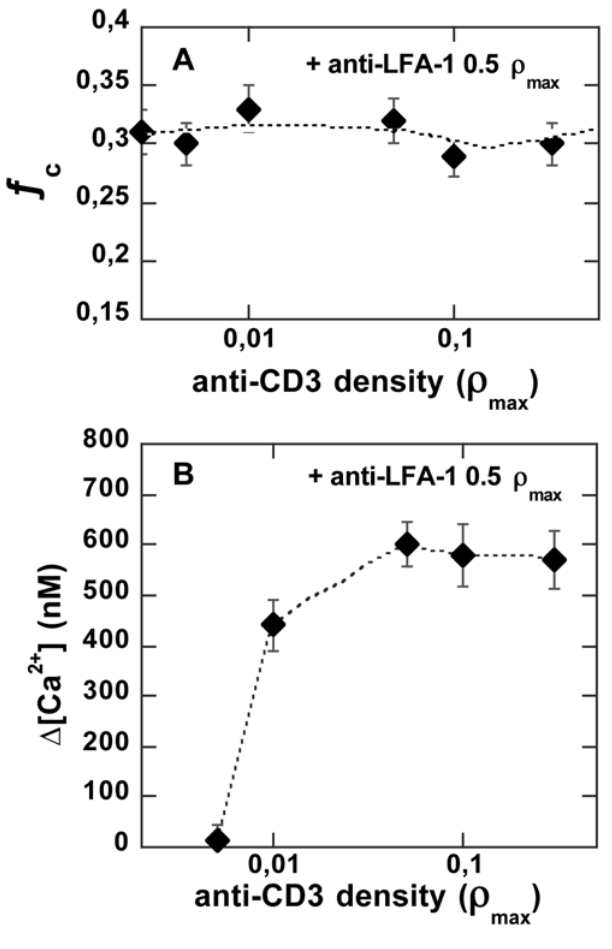
Figure 10. Calcium triggering using hybrid anti-LFA-1 and anti- CD3 grafted particles. (A) Cell-particle binding ratio, e c , and (B) intracellular calcium changes induced by particles grafted with 0.5 r max anti-LFA-1 and anti-CD3 variable densities from 0.005 to 0.3 r max . Conditions as in fig. 2.